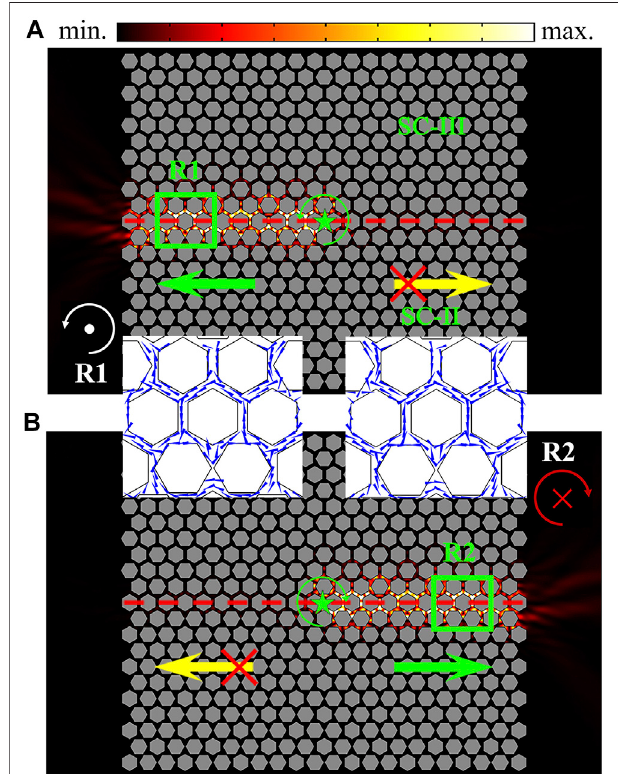
FIGURE 4 | Simulated intensity distributions in the ATI at 16.0 kHz (within the bulk band gap). Two types of chiral sound sources (green stars) withtheoppositechirality(greencirculararrows)areplacedatthecenterofthe domain wall, realizing one-way sound propagation towards the (A) left and (B) right sides along the domain wall. Red dashed lines represent the domain wall, and blue arrows in the zooms R1 and R2 refer to the direction of energy fl